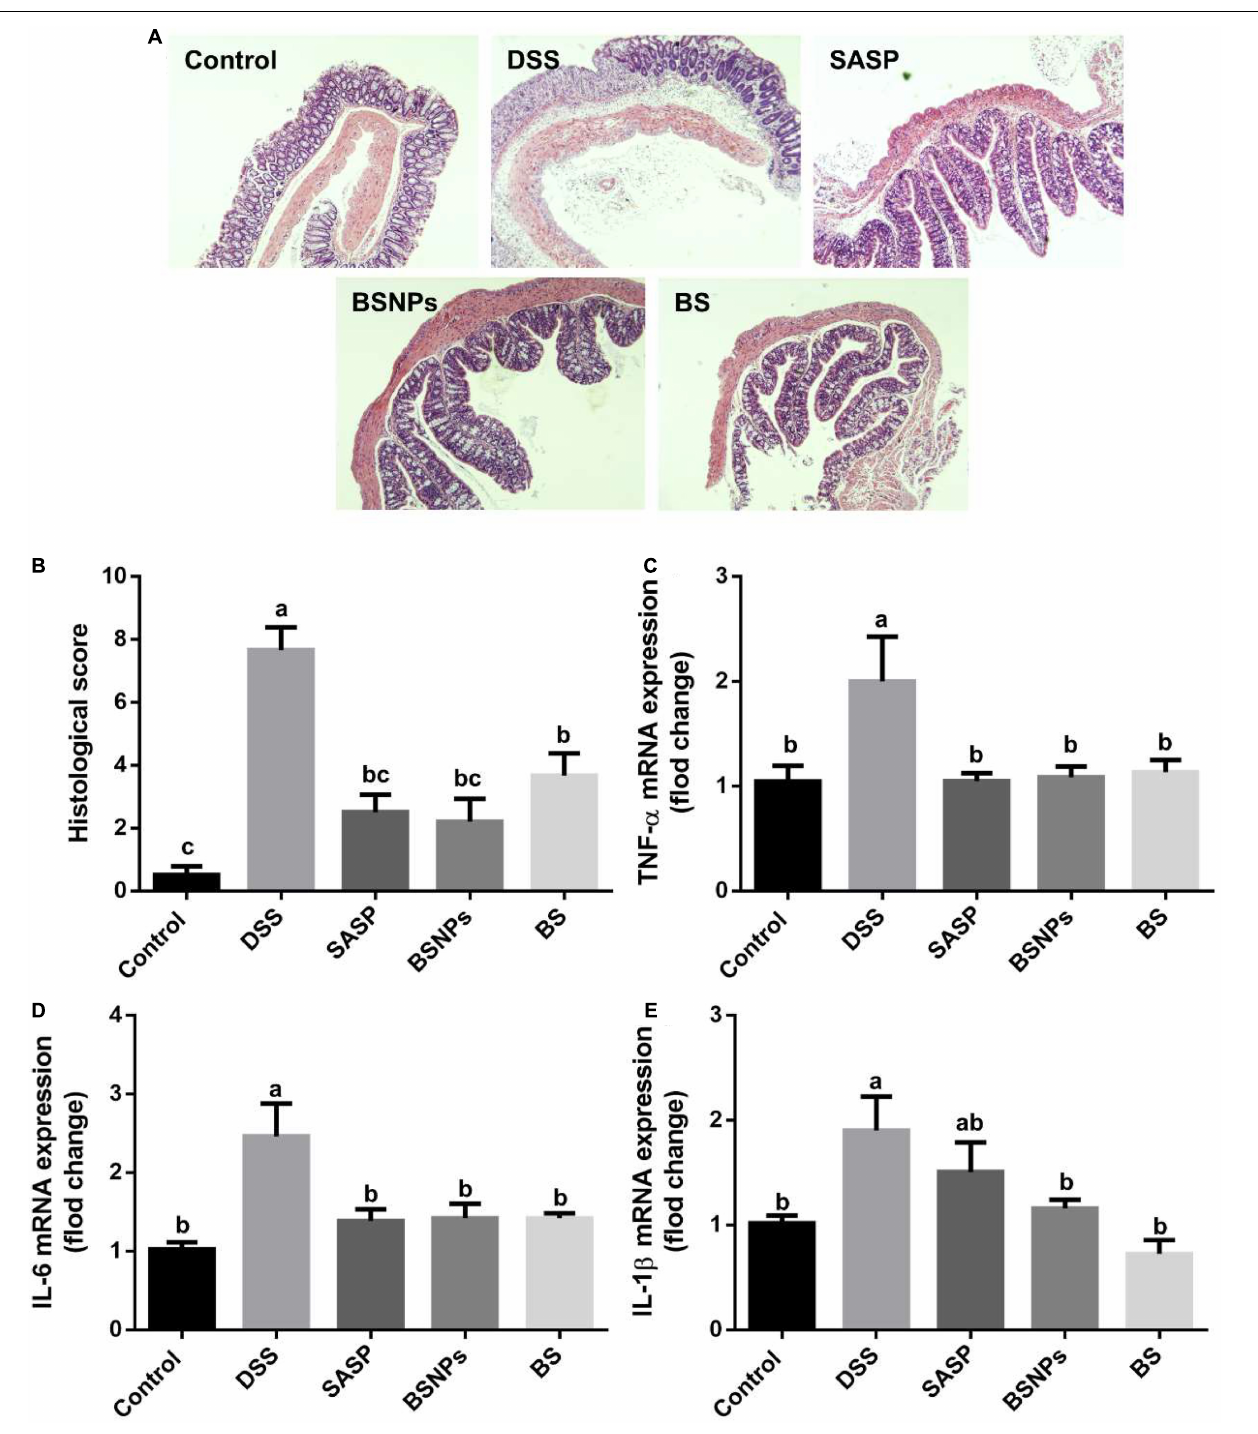
FIGURE 2 | Effect of BS, BSNPs, and SASP treatment on histopathological alteration and inflammatory cytokines in the colonic mucosa of DSS-induced colitis. (A) Representative images of colonic segments. (B) Histological scores. (C) TNF- α expression. (D) Interleukin 6 (IL-6) expression. (E) Interleukin 1 β (IL-1 β ) expression. Values are expressed as the mean ± SEM ( n = 6). Means without a common letter are significantly different at p < 0.05 using one-way ANOVA followed by Tukey’s test for post hoc analysis.